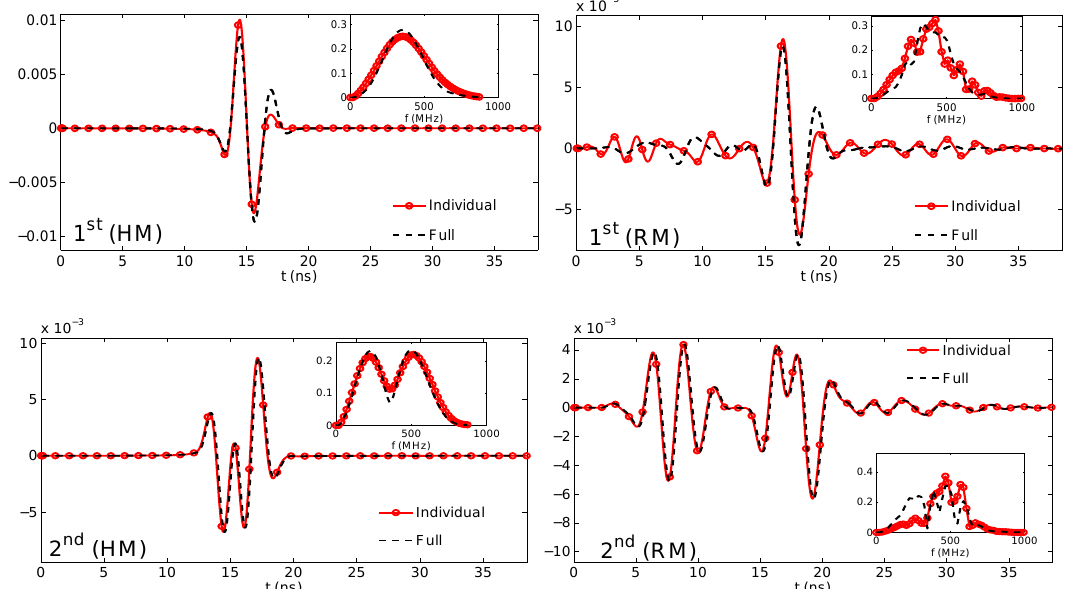
Figure 7. The first two significant time-domain right singular vectors obtained in homoge- neous and random media using both the individual and full